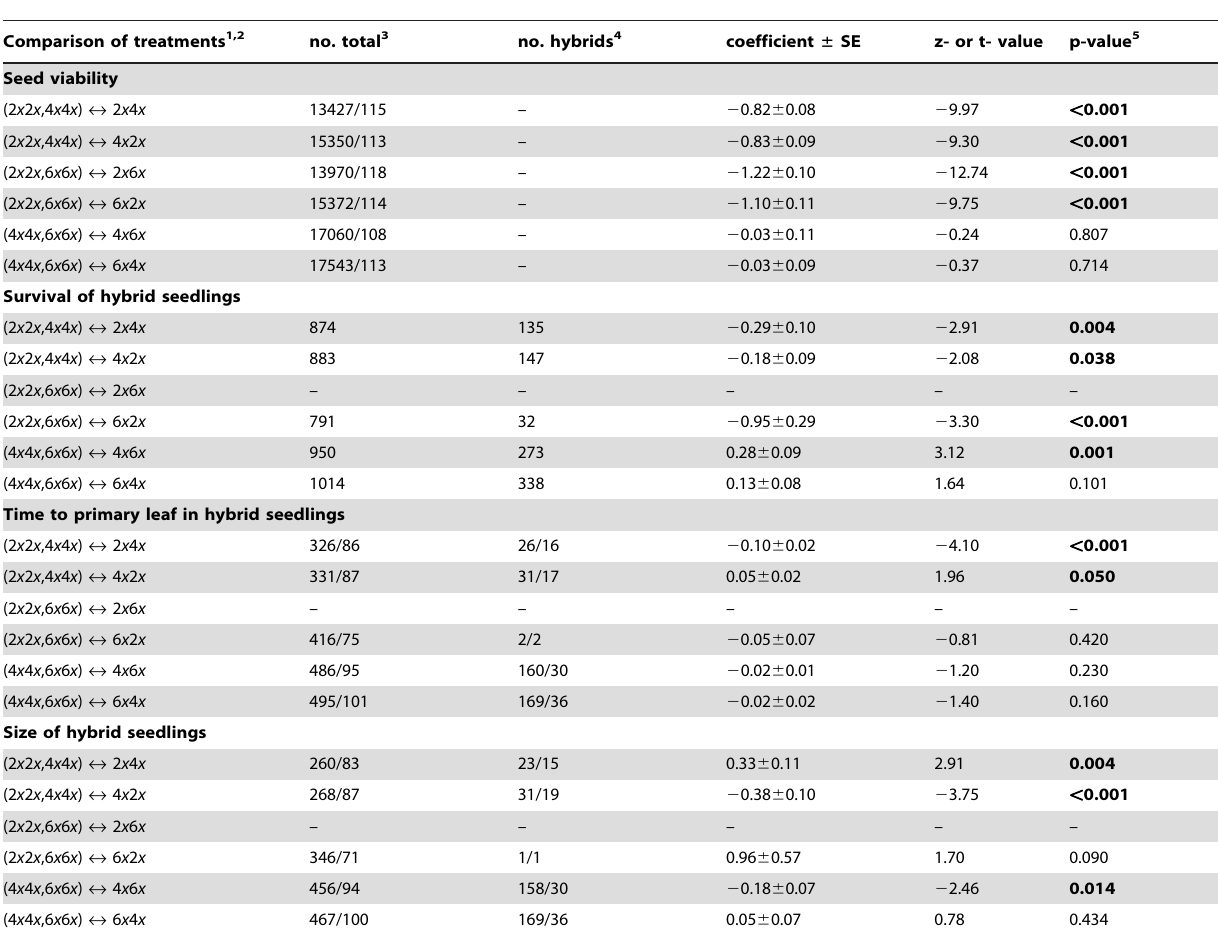
Table 2. Test for intermediacy of fitness components of heteroploid crosses of Jacobaea carniolica .